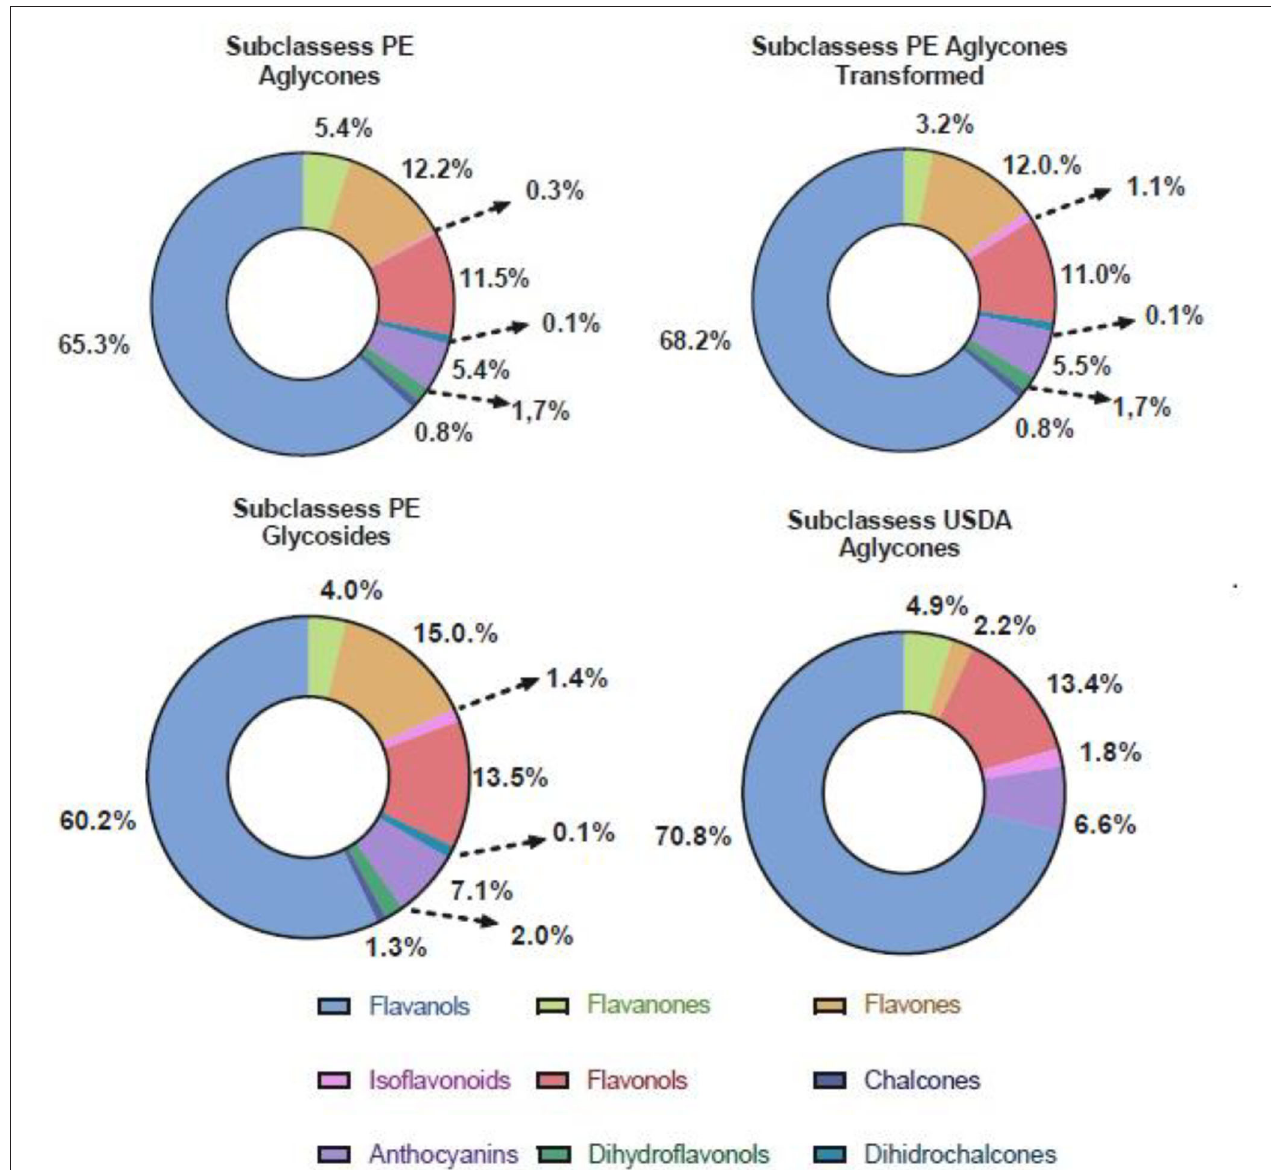
FIGURE 1 | Total percentage distribution of flavonoid subclasses by databases and methods. The Phenol Explorer cake charts include chalcones, dihydrochalcones, and dihydroflavonols. Flavanols from USDA include the proanthocyanidin